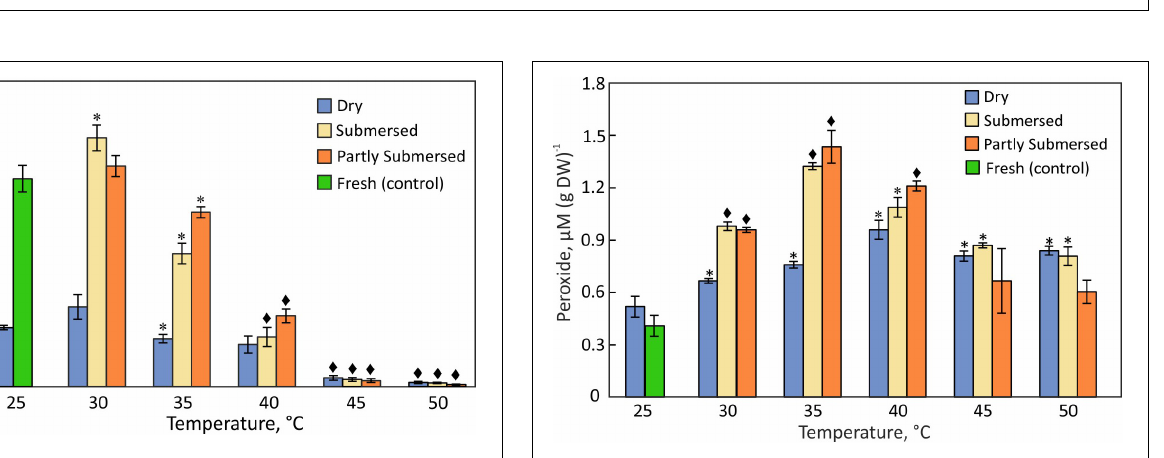
FIGURE 5 | Elemental analysis of leachate from partially (hatched bars) and fully submersed (solid bars) Pleopeltis fronds. Significant differences between heat treated and 25 ◦ C control are indicated by * ( P ≤ 0.05) and (cid:7) ( P ≤ 0.001); means ± SE, n = 3.